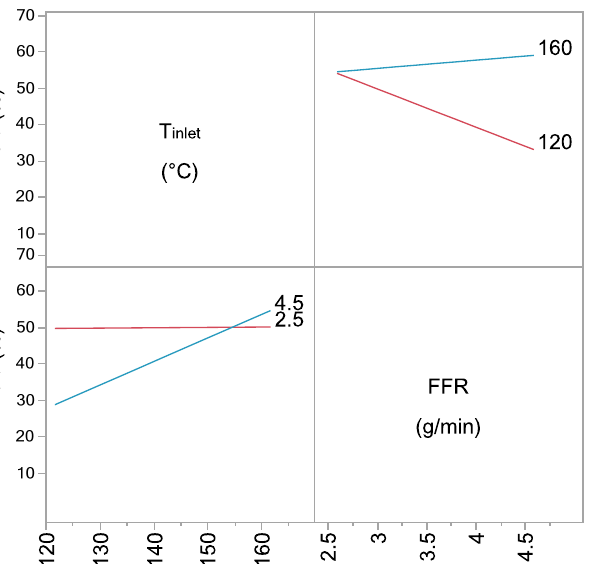
Figure 2. Interaction profiler illustrates the interaction effect between inlet air temperature ( T inlet ) and feed flow rate (FFR).